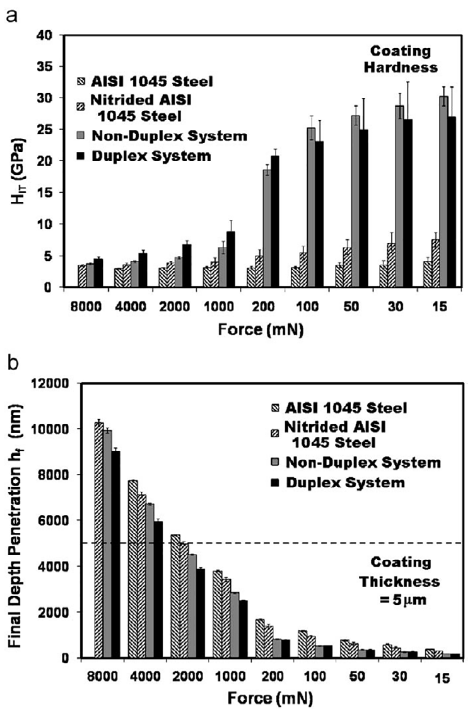
Figure 1. ( a ) Hardness and ( b ) final penetration depth data from nanoindentation measurements carried out as a function of applied force.